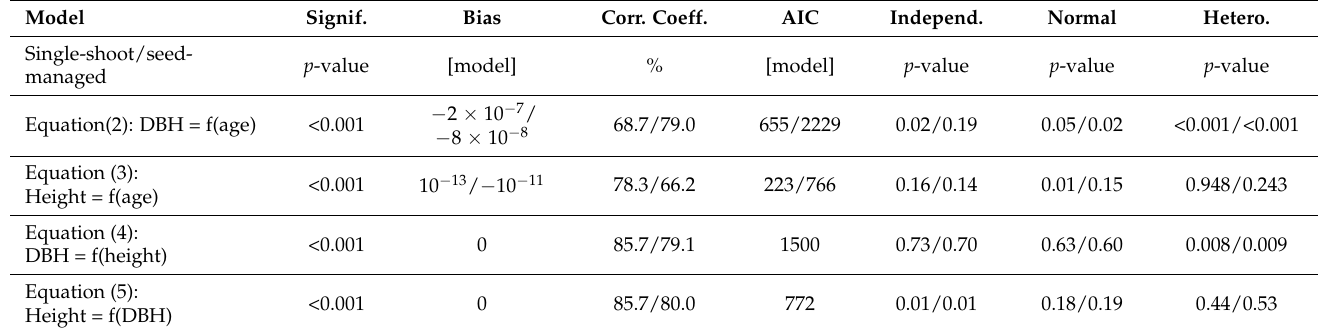
Table 3. Assessment statistics for the DBH and height models. The units for bias and AIC are defined by the model, with cm being the unit for DBH and meters being the unit for height. Signif. represents the significance of the model as computed using the F-test and Independ. stands for the Durbin–Watson autocorrelation